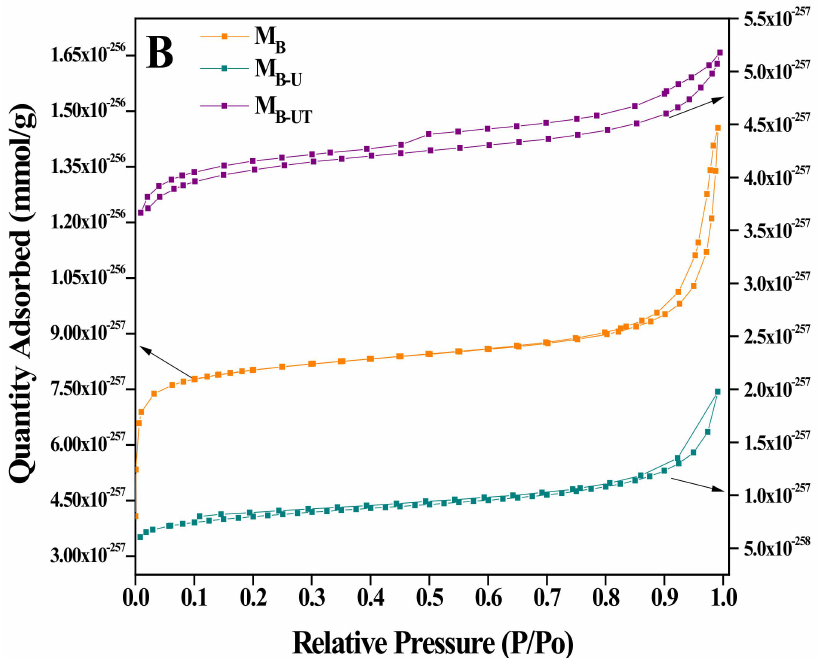
Figure 5. N 2 adsorption–desorption isotherms ( A ) UiO-66 magnetic stirring and ultrasound at room temperature and at 60 ◦ C; ( B ) UiO-66-NH 2 magnetic stirring and ultrasound at room temperature and at 60 ◦ C.